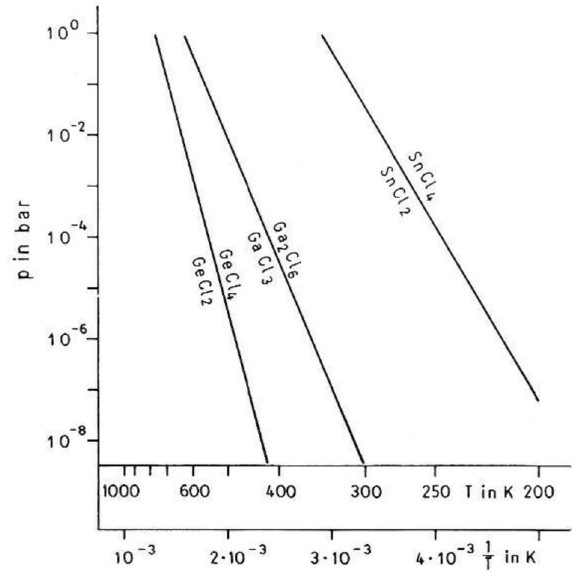
Figure 2. GeCl 2 / GeCl 4 , GaCl 3 / Ga 2 Cl 6 , and SnCl 2 / SnCl 4 dominance changes depending on temperature and total pressure p tot in accordance with equilibrium reaction